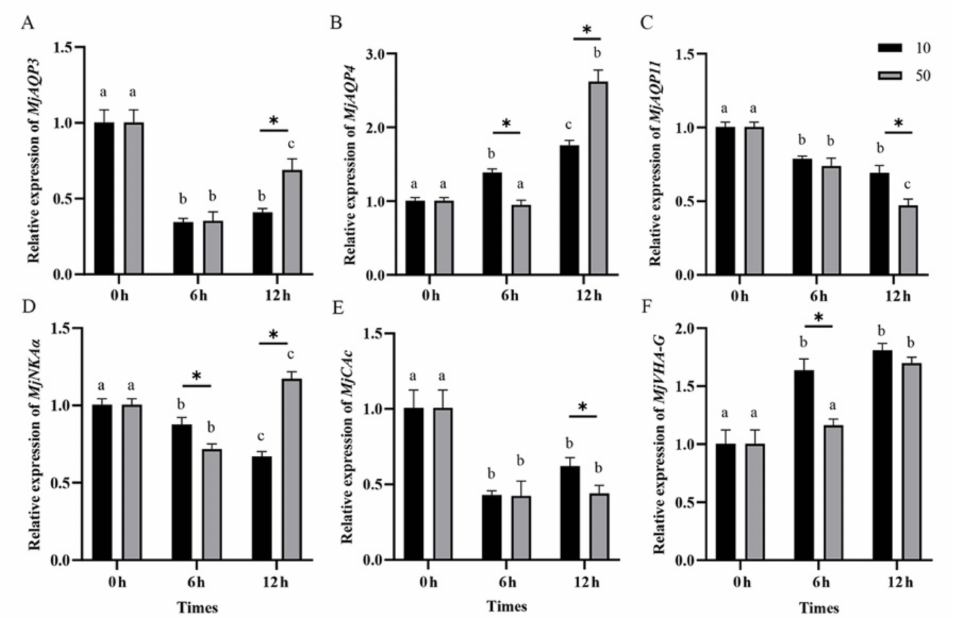
Figure 4. The relative expression levels of ( A ) MjAQP3 , ( B ) MjAQP4 , ( C ) MjAQP11 , ( D ) MjNKA α , ( E ) MjCAc , and ( F ) MjVHA-G in the post-larvae shrimp at 10‰ and 50‰ salinity stresses. The relative expression level of each gene at 0 h is separately used as calibrator. The data are presented as mean + SD ( n = 3). Lowercase letters indicate significant differences ( p < 0.05) with the same salinity at different exposure times. Asterisks above black bars denote significant differences ( p < 0.05) among different salinities at the same treatment